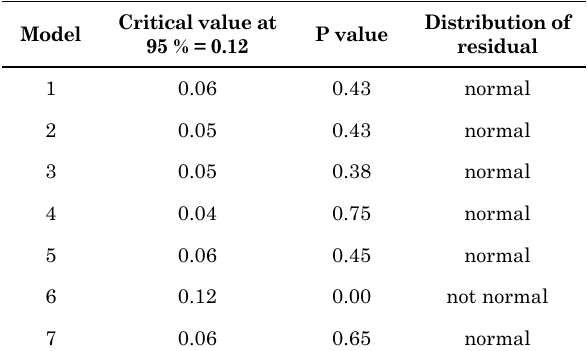
Table 3. Test for normality of residuals (Kolmogorov- Smirnov at 95 % significance) model